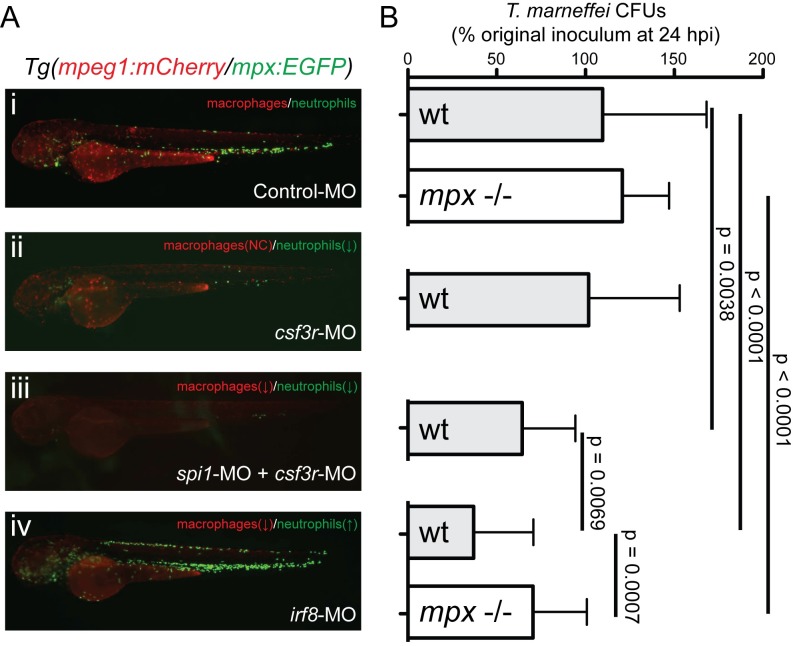
Neutrophils and macrophages play opposing roles during establishment of T. marneffei infection.(A) Representative images of 52 hpf Tg(mpeg1:mCherry/mpx:EGFP) embryos injected with antisense morpholino oligonucleotides to perturb the balance of neutrophil and macrophage populations. (B) T. marneffei CFU numbers at 24 hpi corresponding to the aligned treatment groups in panels (Ai-iv), for wild-type (WT) and myeloperoxidase-deficient (mpx-/-) genotypes as shown. Data are mean±SEM for n≥3 experiments, n≥5 embryos/group/experiment.